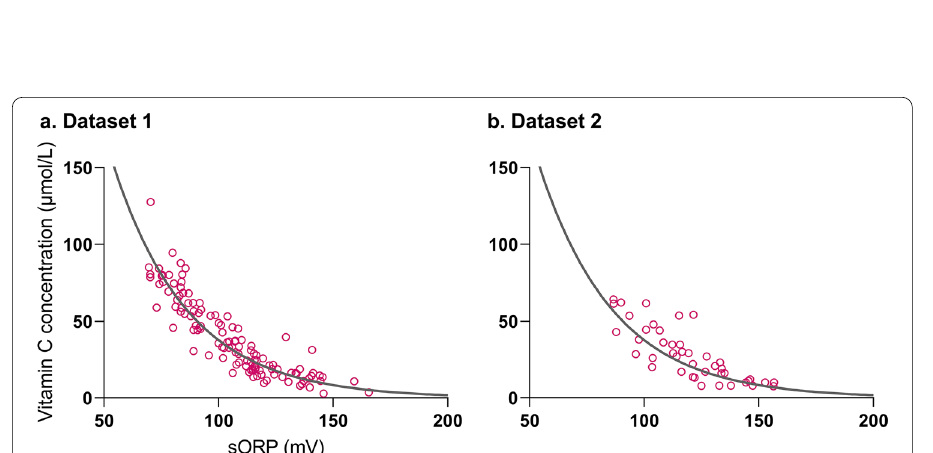
Fig. 2 Scatter plot with exponential model in thawed plasma samples (n plasma samples ( n 43), dataset 2 ( b ). Equation: plasma vitamin concentration = 785.19 e − 0.030 =